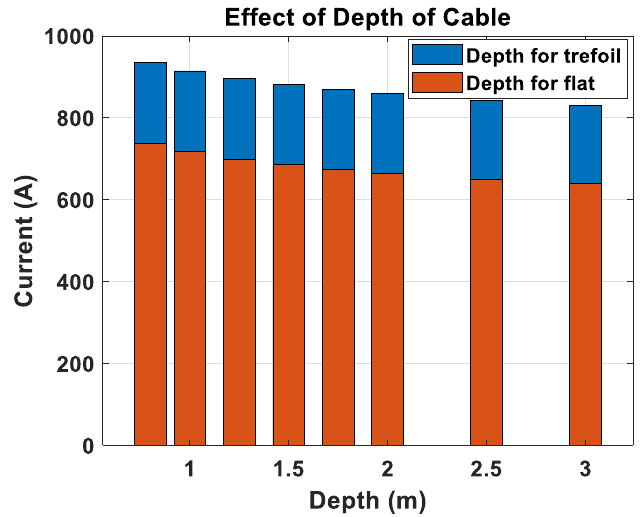
Figure 10. Effect of cable depth on the cable ampacity.